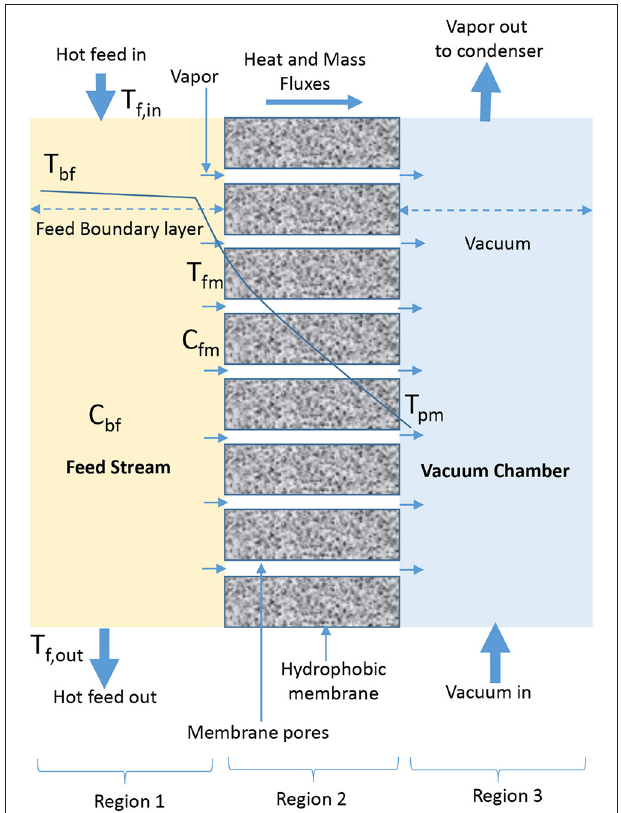
FIGURE 2 | Heat and mass transfer in VMD configuration (adapted from Khayet and Matsuura,